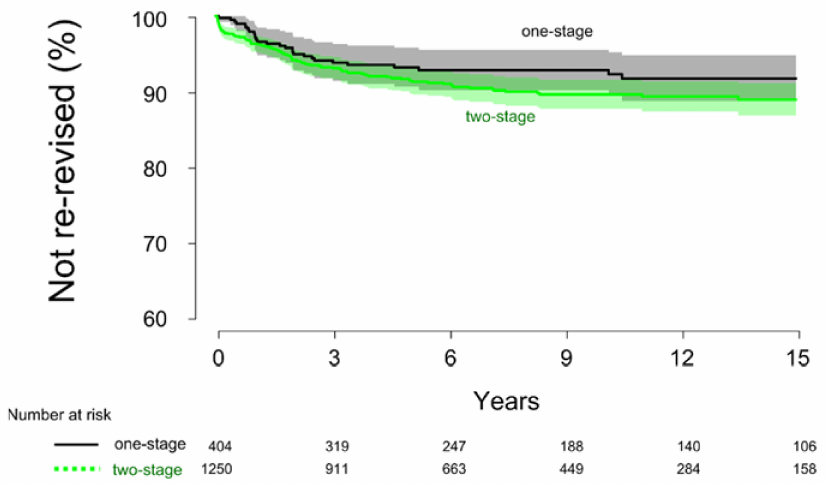
Figure 3. The cumulative survival rate at 15 years after surgery using re-revision due to infection as the endpoint. The survival rate was similar between the one- and two-stage procedures ( p = 0.13).